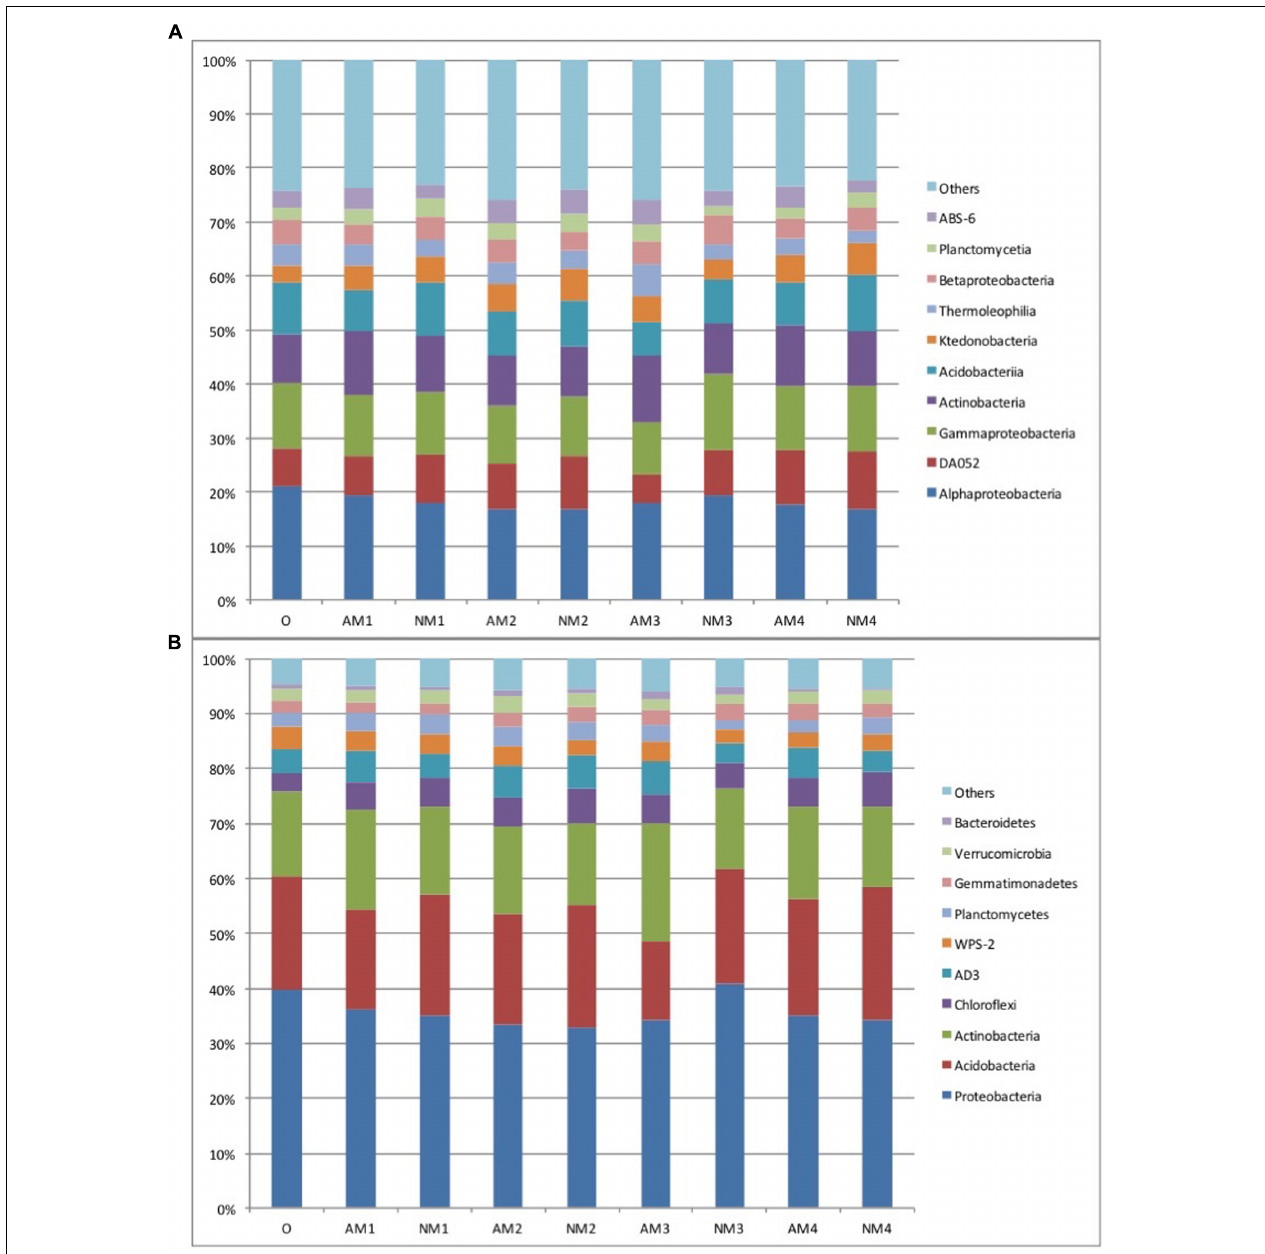
FIGURE 1 | The relative abundance of the dominant bacteria class (A) and phyla (B) in soil samples derived from the different treatments and sampling times used in our study. Abbreviations: AM represents the treatment inoculated with arbuscular mycorrhizal fungi, NM represents the uninoculated treatment, while O stands for the original soil collected from the forest. Different numbers (1, 2, 3, and 4) represent the different sampling times (T 90 , T 120 , T 150 , and T 180 , respectively). Relative abundance ( > 1%) is based on the proportional frequencies of those DNA sequences that could be classified at the phylum or class levels. Phylogenic groups that account for less then 1% of all classified sequences are divided into the artificial group